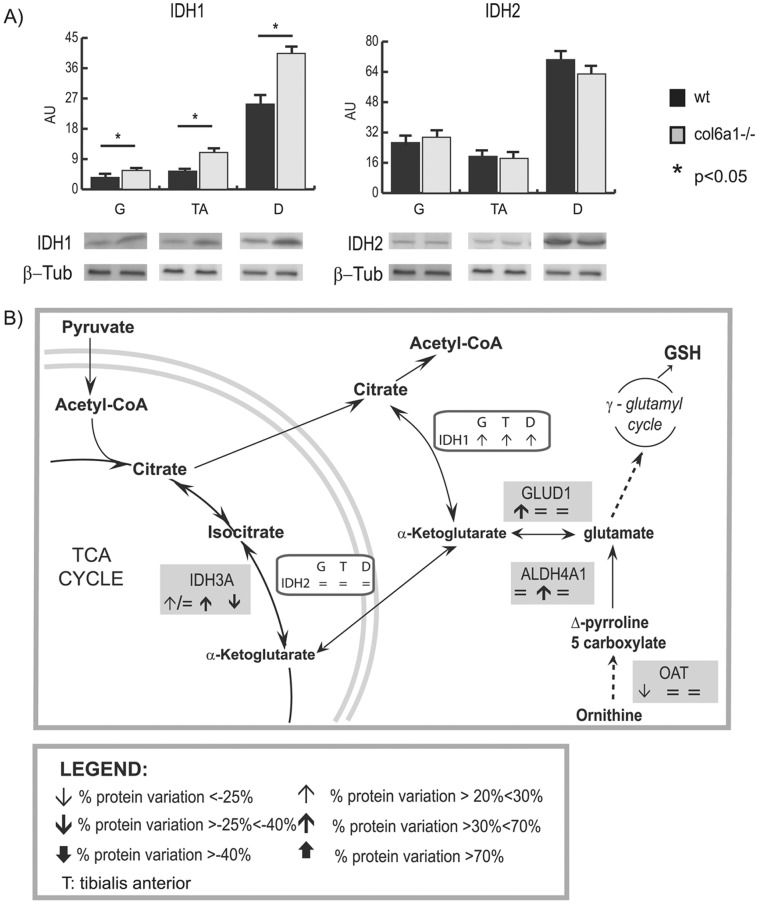
Immunoblotting and 2D-DIGE results on proteins involved in glutamate metabolism.Panel A: Histograms and representative immunoblot images of IDH1 and IDH2 in gastrocnemius, tibialis anterior and diaphragm from Col6a1
−/− and wild-type mice (n = 4; mean ± S.D.; Student’s T-test). Panel B: schematic representation of IDHs pathways. Grey and empty rectangles contain gene names of deregulated proteins observed by 2D-DIGE and western blotting, respectively. Arrows indicate the protein trend in gastrocnemius (G), tibialis anterior (T) and diaphragm (D). For 2D-DIGE, the arrows direction indicates up- and down-regulation, the thickness the % of spot variation.  = /↓ or  = /↑ indicate the differential expression of isoforms of the same protein in a given muscle. For western blotting, the arrows direction indicates the up- and down-regulation of relative variation of Col6a1
−/−
versus control wild-type muscle.